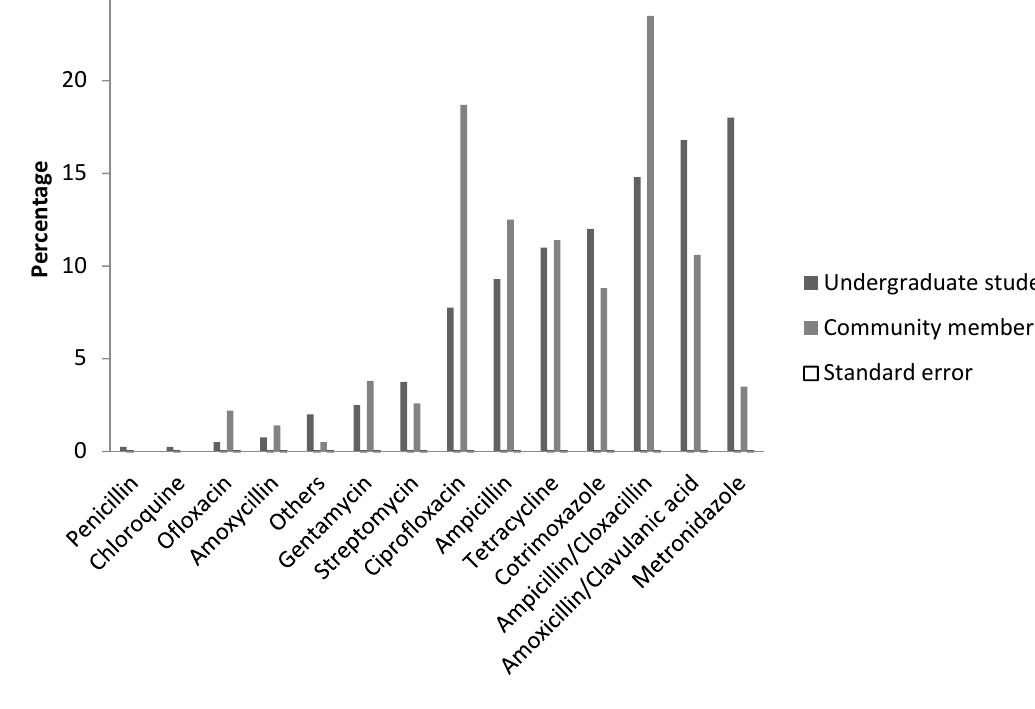
Figure 1. Commonly used antibiotics.